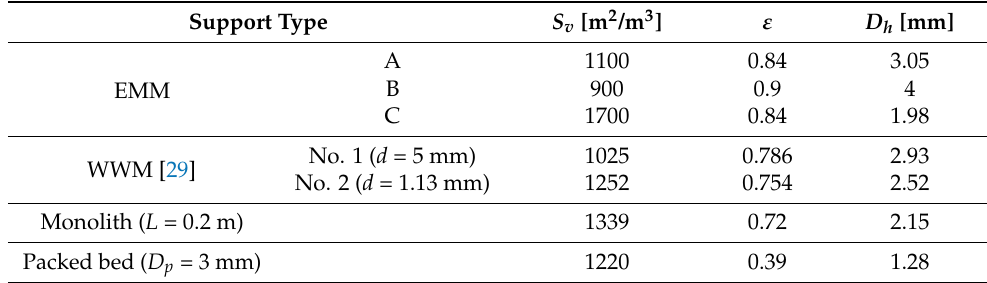
Figure 10. Comparison of Performance Efficiency Criterion of different reactor packings.